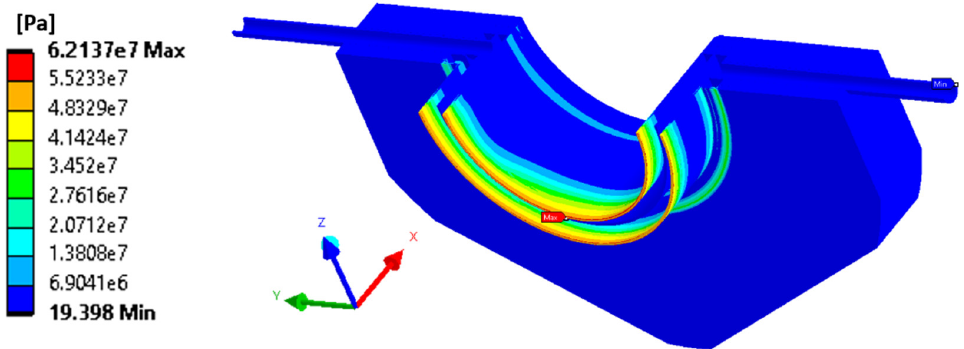
Figure 7. Equivalent von Mises stress distribution in the metallic parts of the window for the reference case.